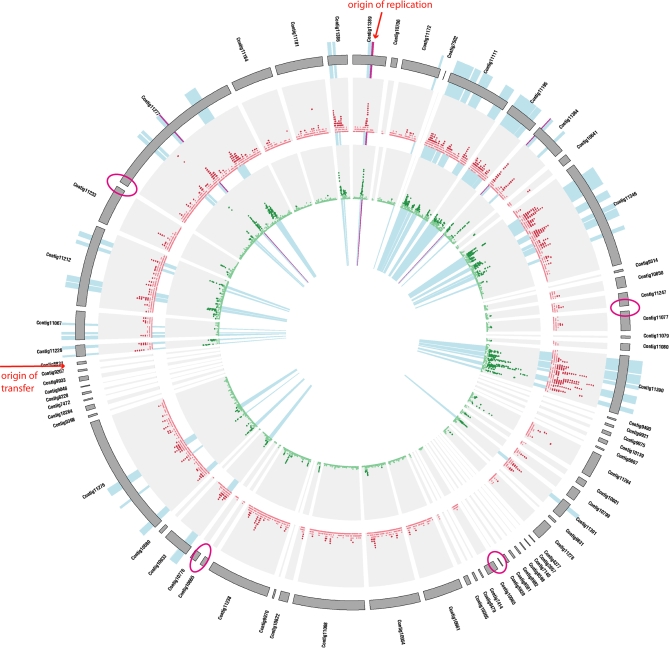
The Genome of Leptospirillum group II, Showing That SNP Density and Frequency Are Roughly Symmetrical around the Origin of ReplicationCircular diagram showing contig ordering, SNP density, minor allele frequency, and location of strains around the genome. The outer ring shows all contigs in the 5-way CG assembly, ordered by mate pairing and by reference to the UBA genome. Four locations where the join is uncertain are circled in magenta. The first inner ring shows a moving average of SNP density (1-kb windows, 50-bp slide, scale 0–1). Dark red indicates local SNP density of greater than 0.5% while pink indicates less than 0.5%. The second inner ring shows a moving average of minor allele frequency (scale 0%–0.7%). Dark-green points indicate average minor allele frequencies for a window greater than 0.05%. Light-blue highlights indicate location of substrains used to analyze variation within the 5-way CG population (>99% sequence similarity). Purple highlights indicate the location of deeply sampled reads of more divergent Leptospirillum group II strains incorporated into the population (∼94% sequence similarity). The image was generated with Circos (M. Krzywinski, http://mkweb.bcgsc.ca/circos/).